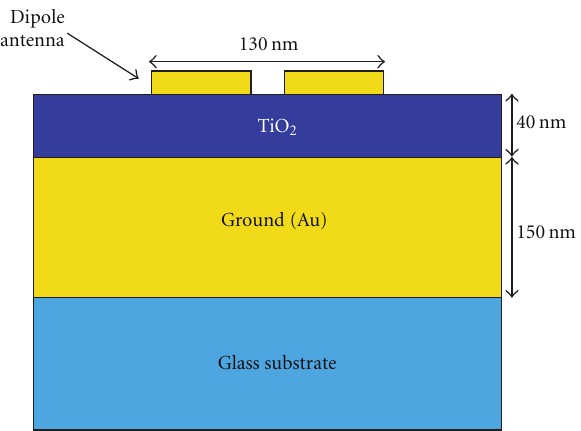
Figure 1: Multilayer substrate to control the radiation pattern of a dipole antenna. Thicknesses of ground plane, dielectric (TiO 2 ) spacer, and top gold layer are 150 nm, 40 nm, and 50 nm, respec- tively. Dipole antenna length of 130 nm with a 20nm feed gap was used to operate at wavelength of 840